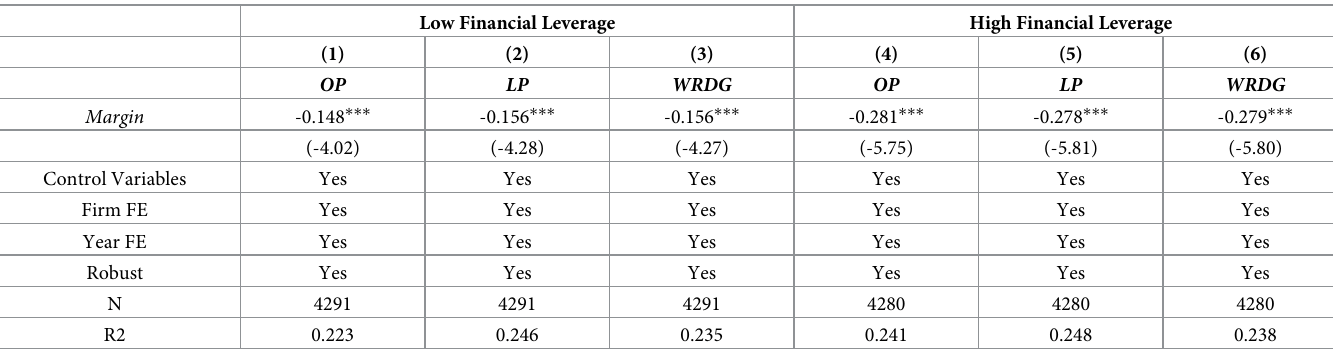
Table 7. Cross-sectional analysis by financial